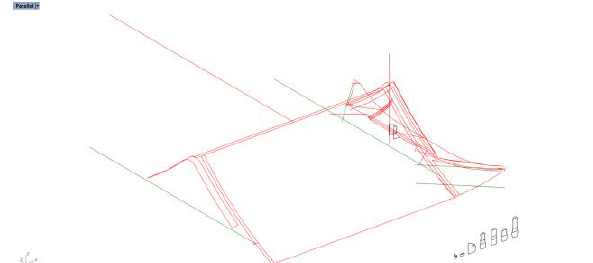
Figure 15. Skeleton lines for the roof of Main Hall of Lu Ban Shrine, Jizhou, Tianjin, extracted from point cloud